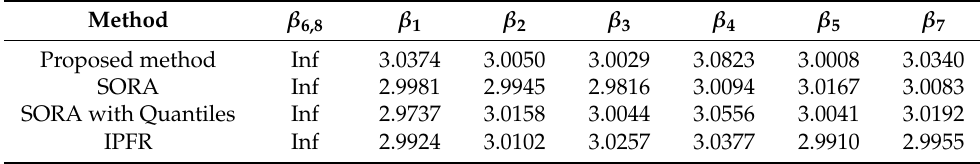
Table 6. Probabilistic constraints comparison of the Hock and Schittkowski